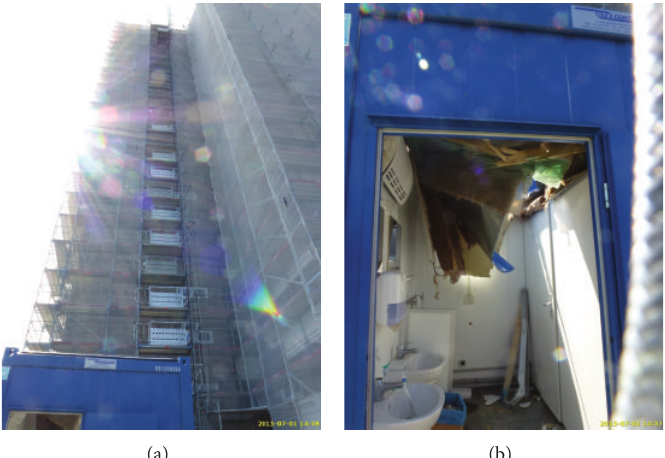
Figure 1: Pictures from the accident scene: (a) the scaffolding from which the patient fell is visible, (b) the destroyed rooftop of the toilet container after